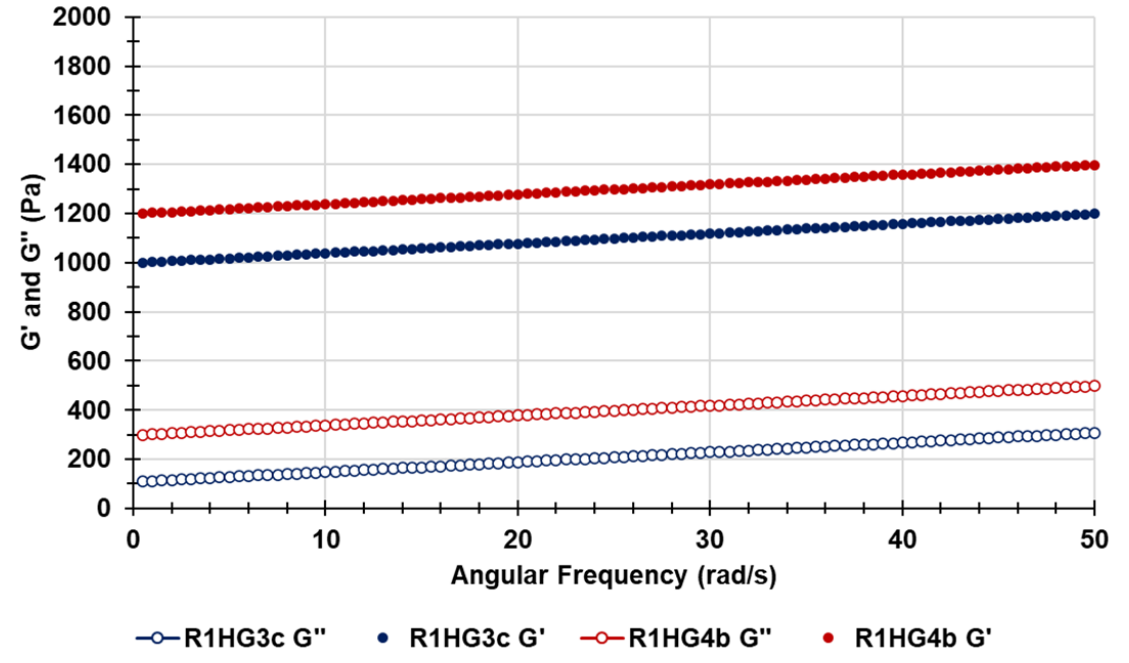
Figure 18. Elastic/storage modulus (G ′ ) (filled indicators) and viscous/loss modulus (G ″ ) (empty indicators) vs. angular frequency (ω) of R1HG -3c (blue graphs) and R1HG-4b (red graphs).